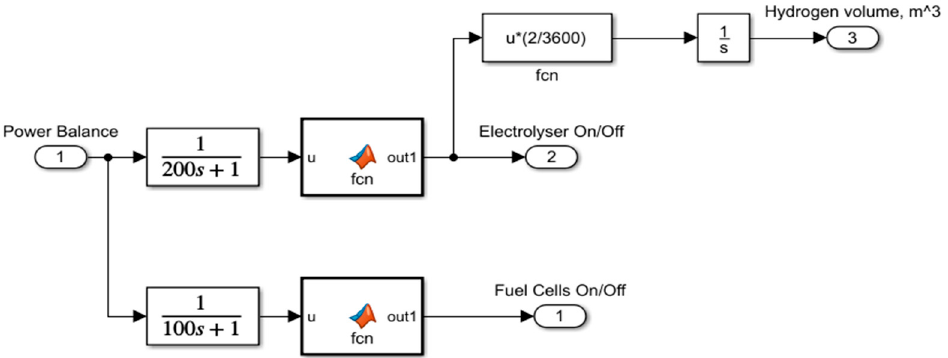
Table 2. Parameters of the VOLTIANA electrolyzer. Parameter Value Unit Capacity, as hydrogen